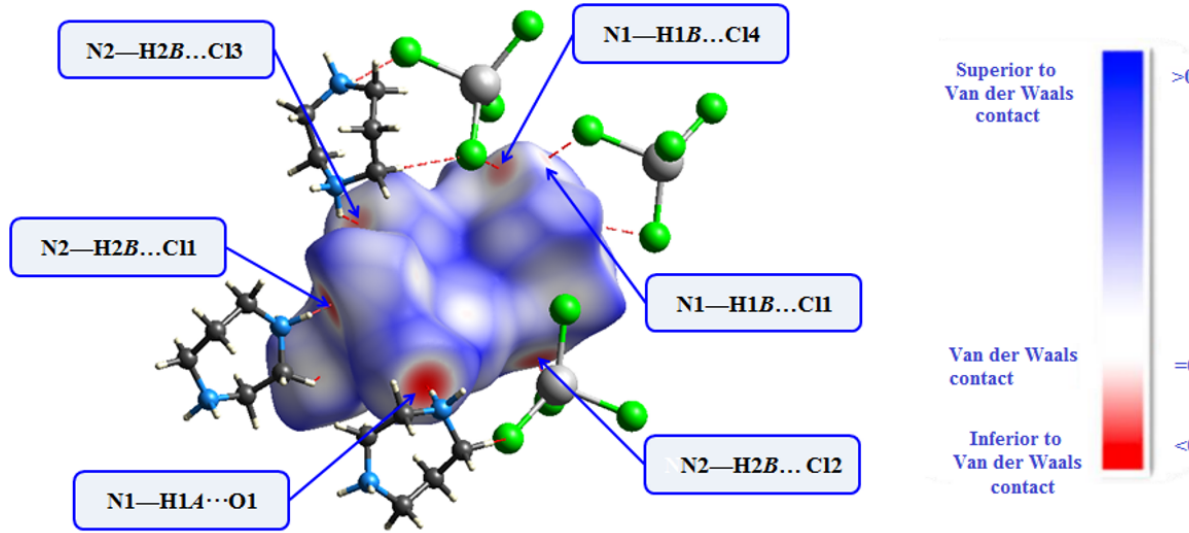
Figure 6. H-Bonds present in the (C 5 H 14 N 2 )[HgCl 4 ]·H 2 O compound.